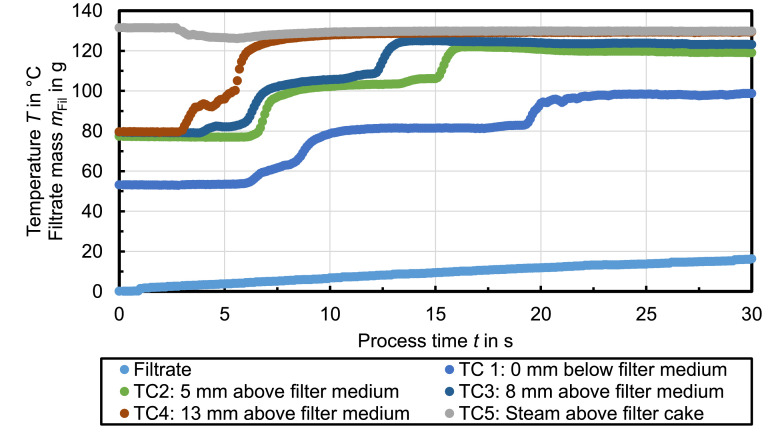
Celite®512 & n-heptane (Δp = 1.7 bar, Tst = 130°C, hFC = 20 mm); RM = 7.4 %, rC = 9 × 1012 1/m²